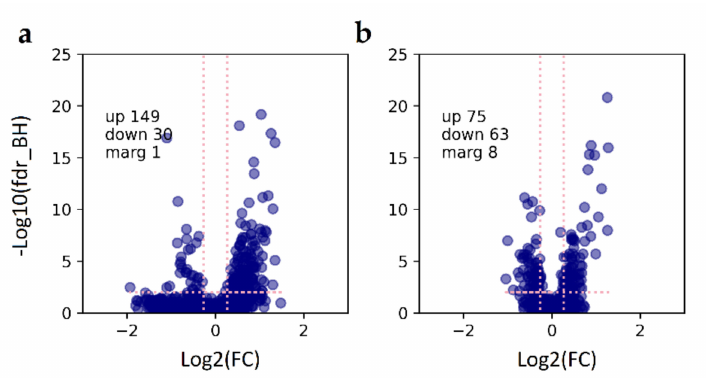
Figure 5. Comparison of DBTRG-05MG cells with silenced IFIT3 ( a ) and PLSCR1 ( b ) with the parental DBTRG-05MG cells at the proteome level. Differentially regulated proteins satisfy fdr_BH < 0.01 and FC ≥ 1.2. Statistical significance was calculated with Diffacto [43] adapted for use with TMT11plex